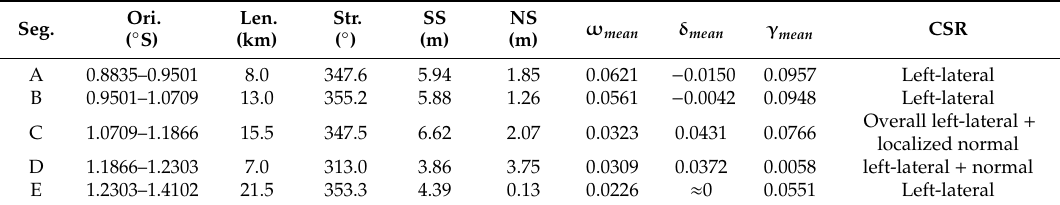
Table 2. Characteristics and geometric variation of surface rupture within the Palu basin.